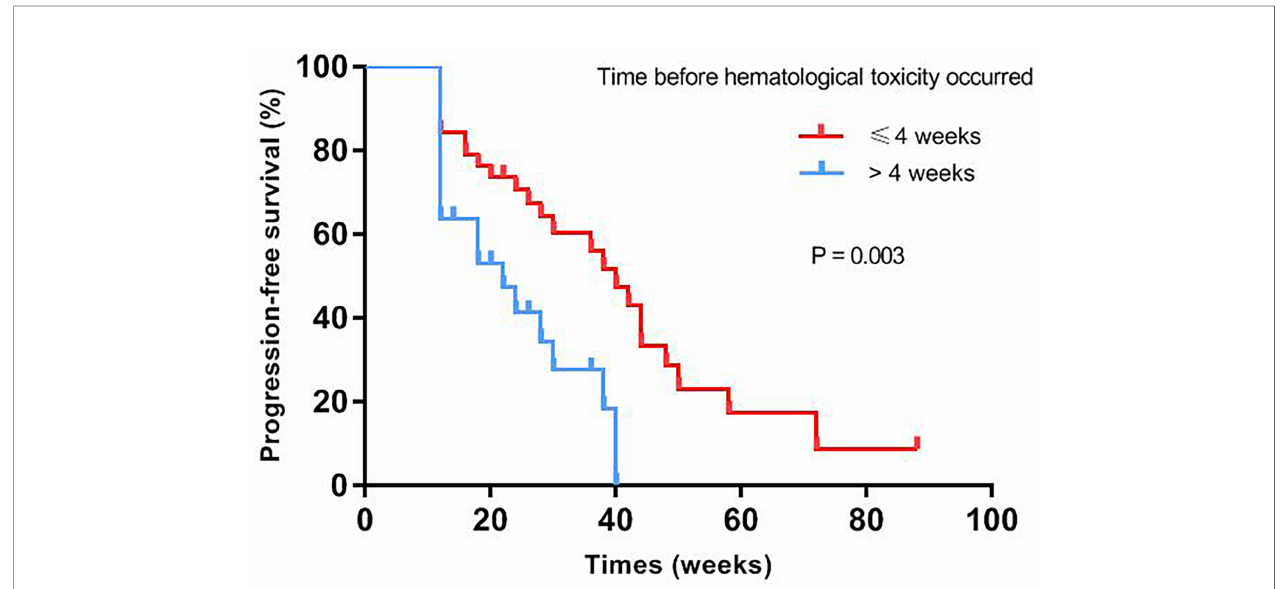
FIGURE 2 | PFS was compared between patients with hematological toxicity within 4 weeks or after 4